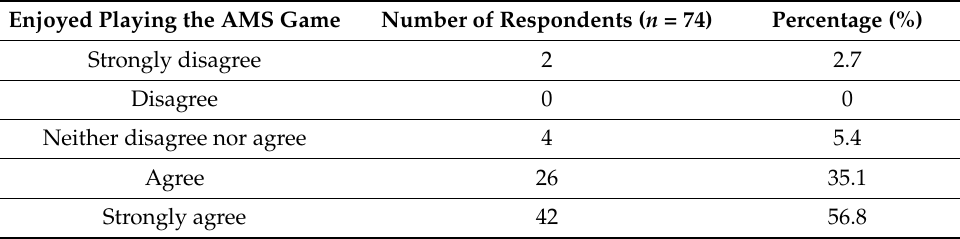
Table 3. Enjoyment playing the AMS